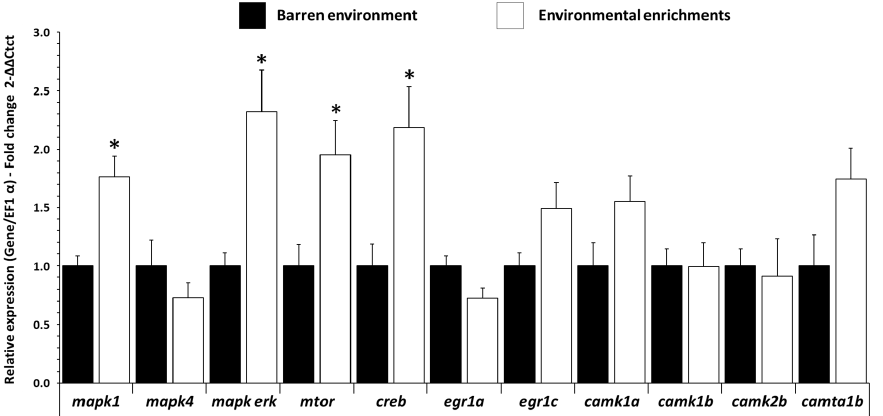
Figure 4. Plasticity factors related to mRNA level in forebrain of trout raised in a barren environment (black) or environmental enrichments (white) for three months. Values are expressed as group mean ± SEM; fold change vs. barren environment for all genes; Welch’s t -test, Tukey post hoc; differences between treatments are represented by * ( p < 0.05). Replicates (n = 8) correspond to different individual